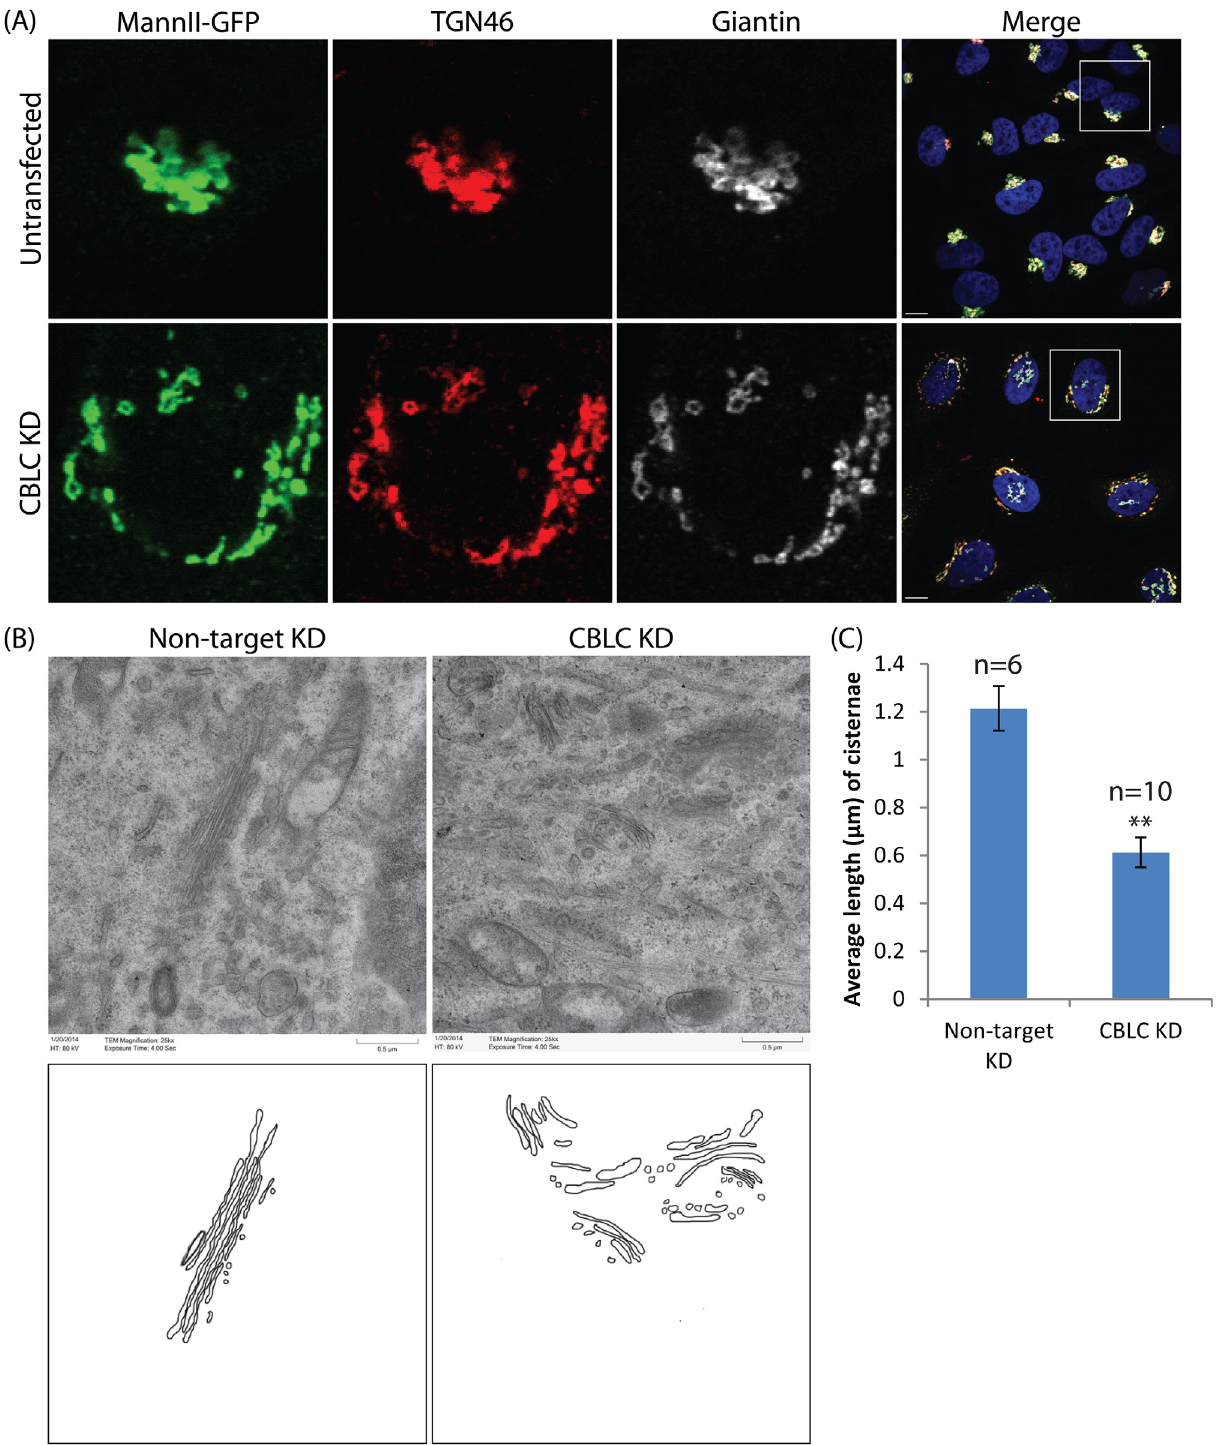
Fig 2. CBLC regulates Golgi ribbon formation. (A) Immunostaining of Golgi using Mannosidase II (green), TGN46 (red) and Giantin (white). Scale bar = 10 μ m (B, C) Electron microscopy reveals intact but shorter Golgi stacks in CBLC-depleted cells. Scale bar = 0.5 μ m.